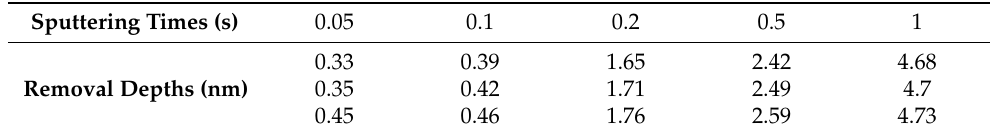
Table 2. Removal depths at different cumulative sputtering